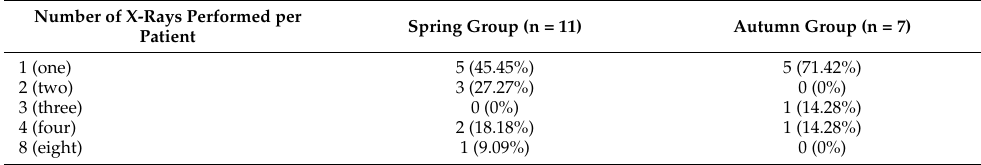
Table 5. Number of chest X-rays performed per